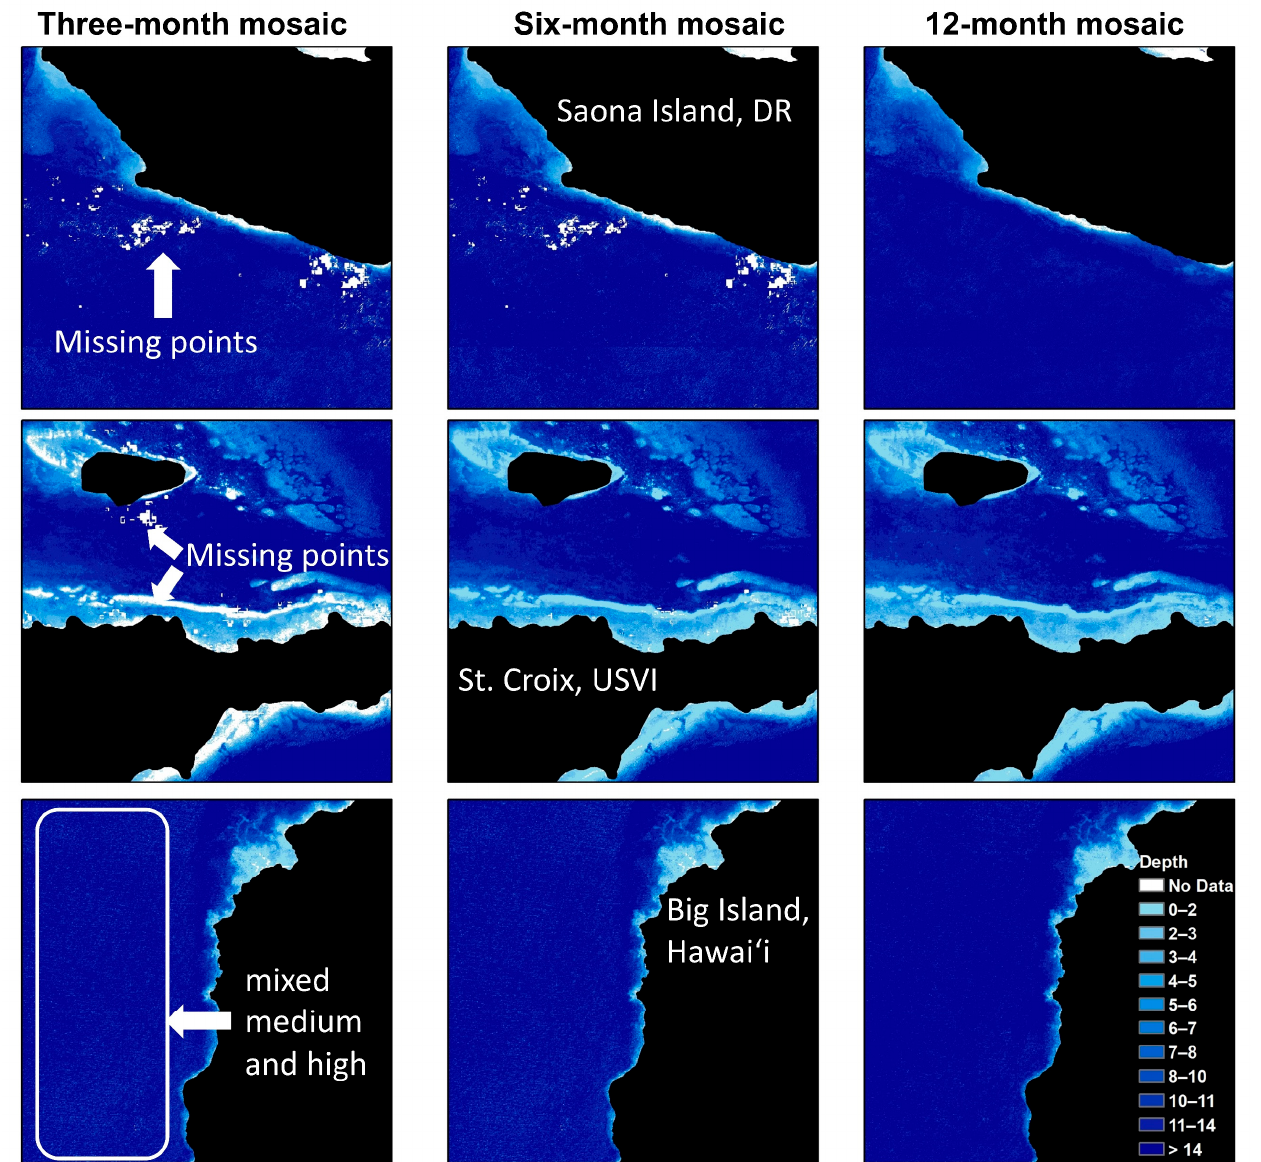
Figure 6. Sentinel-2 bathymetric models based on different temporal mosaic composites. As the time frame selection is increased, the quality of the mosaic also increases, resulting in fewer data gaps and more accurate bathymetric models. The white color represents the missing points in the bathymetry results.